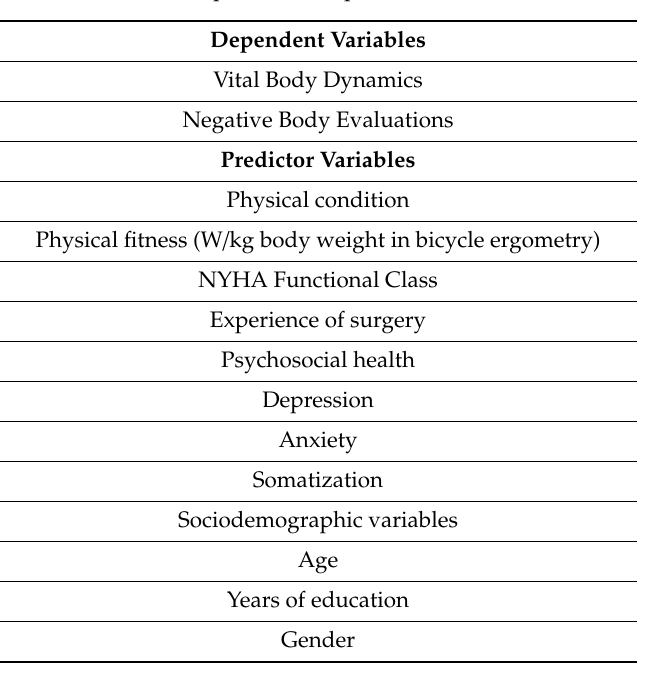
Table 1. Dependent and predictor